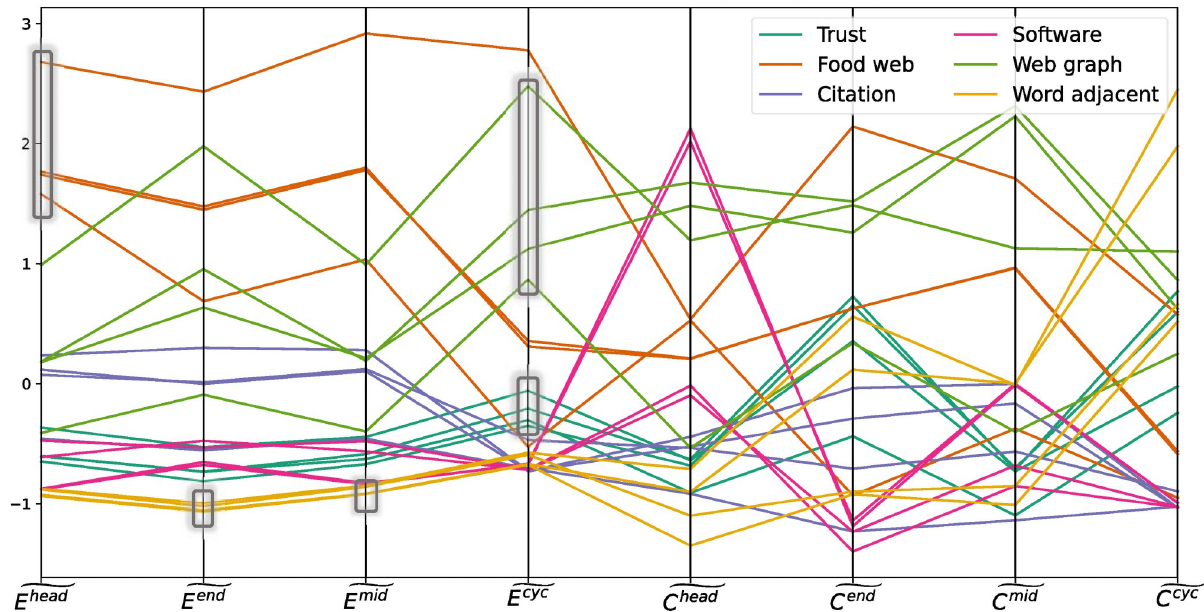
Fig 9. Parallel coordinates plot of 24 networks on eight features, including the four closure patterns and the four clustering patterns. Each vertical axis represents one feature. In order to put all features on a similar scale, the value of each feature is standardised by removing the mean and scaling to unit variance. Different types of networks are painted in different colours, as shown in the legend. Distinct braids of line segments are highlighted by thin rectangles.